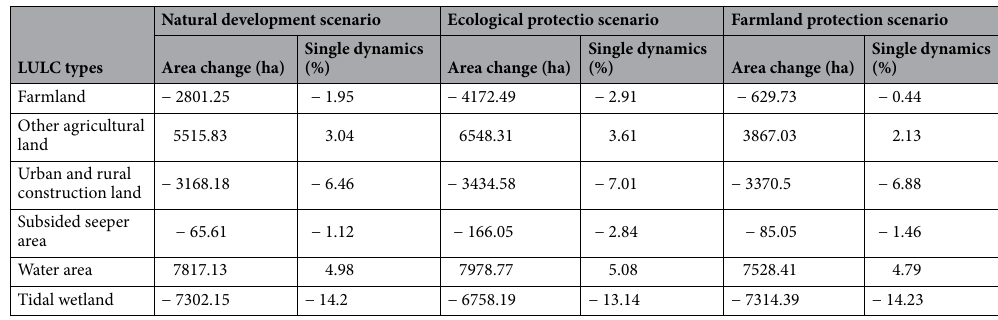
Table 6. Dynamic change of LULC types under different scenarios from 2017 to 2025.